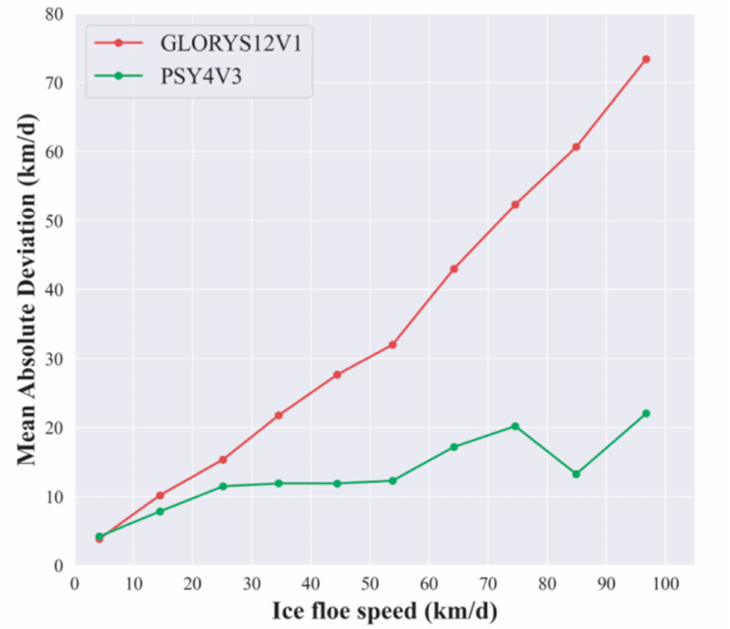
Figure 10. Variations in the mean absolute errors of the sea ice motion products versus the ice floe speed from Sentinel-1 with changes in ice